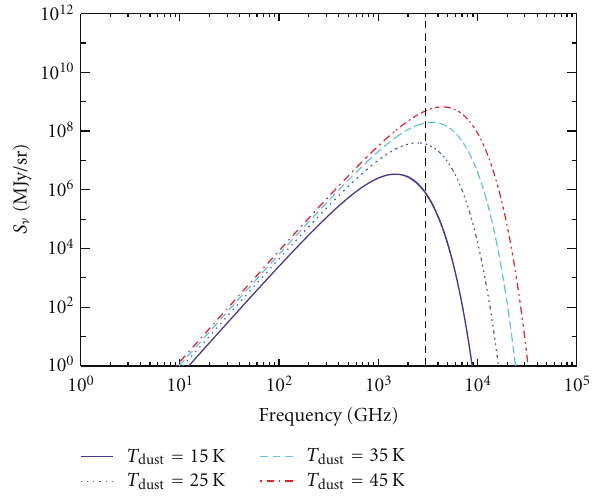
Figure 1: The modified black body spectrum representing the ther- mal dust emission for a range of dust temperatures from 15 to 45 K with a fixed dust emissivity spectral index of 1.8. This illustrates how the 100 μ m emission (vertical dashed line) increases with increasing dust temperature, and hence how the AME emissivity defined relative to the 100 μ m emission is biased by changes in dust